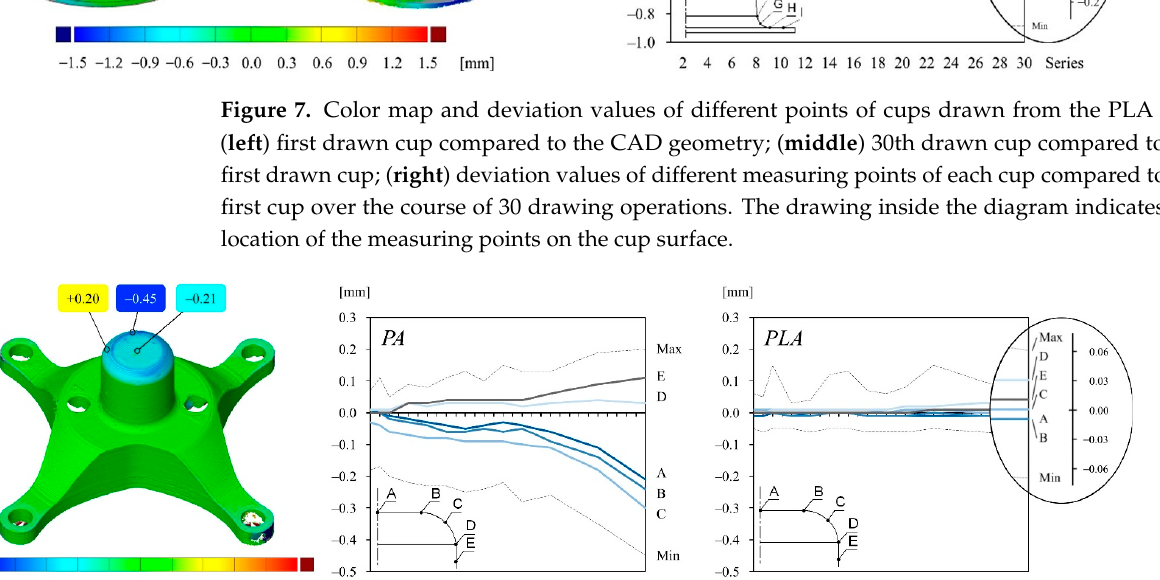
the initial stamp geometry of both material configurations: ( left ) selected measuring points; ( mid- dle ) deviation values of PA stamp over the course of 30 drawing operations; ( right ) deviation values of PLA stamp over the course of 30 drawing operations. The drawing inside the diagram indicates the location of the measuring points on the punch surface. The graphs and the color map of Figure 9 are structured in the same way as shown in Figure 8. However, the wear on the die is illustrated instead. The deviation values of the PA die are a bit less than on the PA stamp, ranging from − 0.33 mm to 0.19 mm over the course of 30 drawing operations. In contrast, the wear on the corner radius of the PLA die is higher compared to the wear on the stamp, but still less than the wear on the PA die.